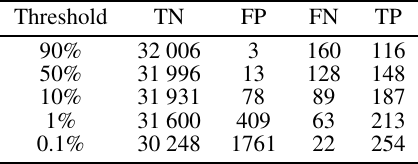
Table 3. Results for confusion matrix based on different